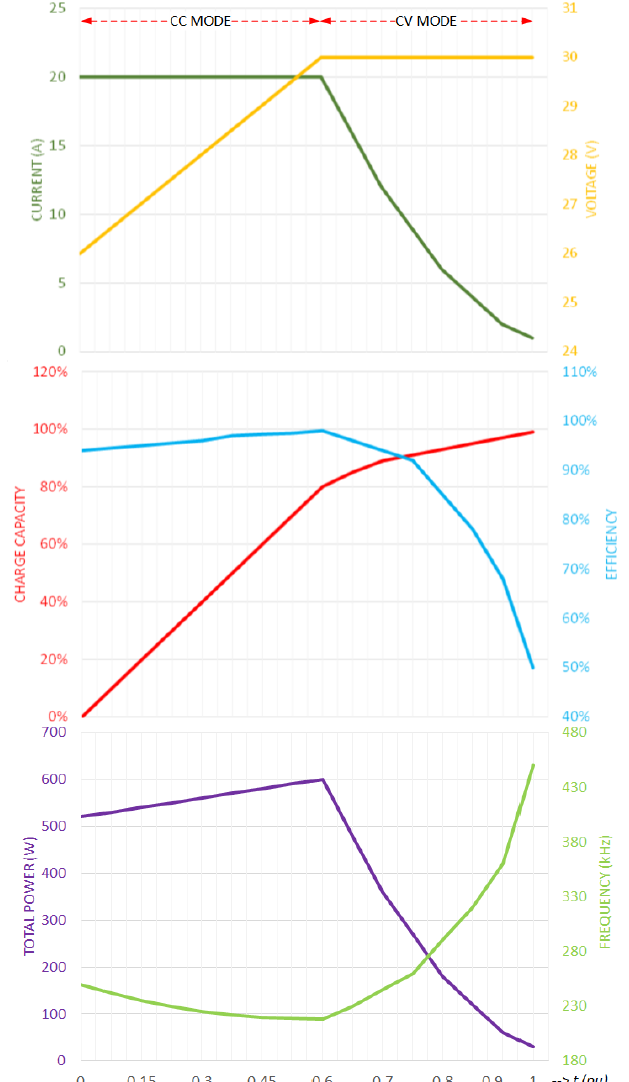
Figure 1. Battery charge profile of LLC resonant